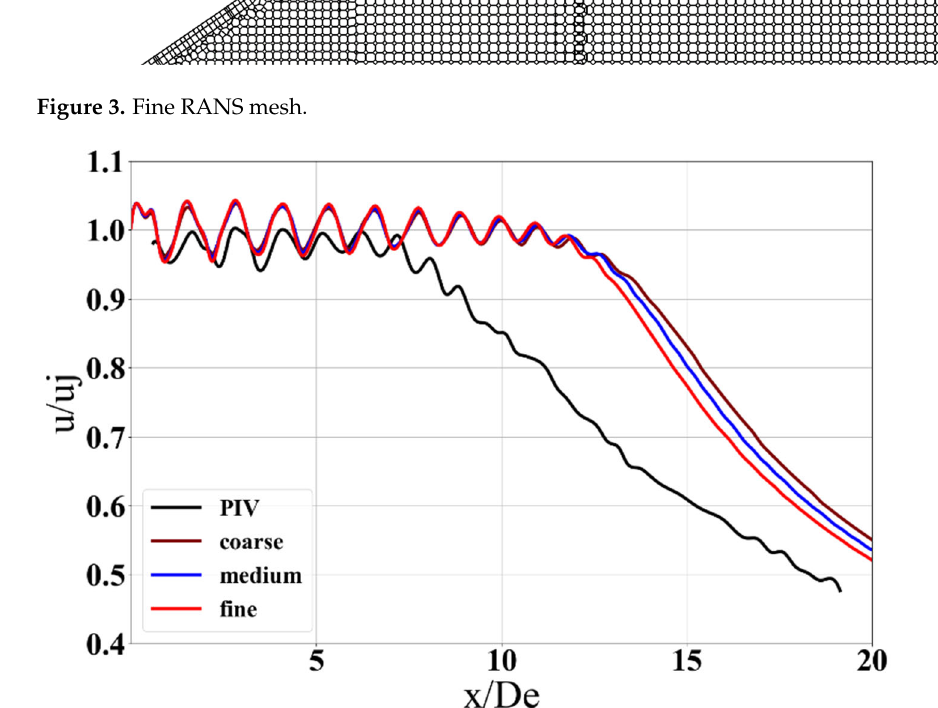
Figure 4 . Mesh sensitivity study for jet centerline velocity compared with PIV data from [60].